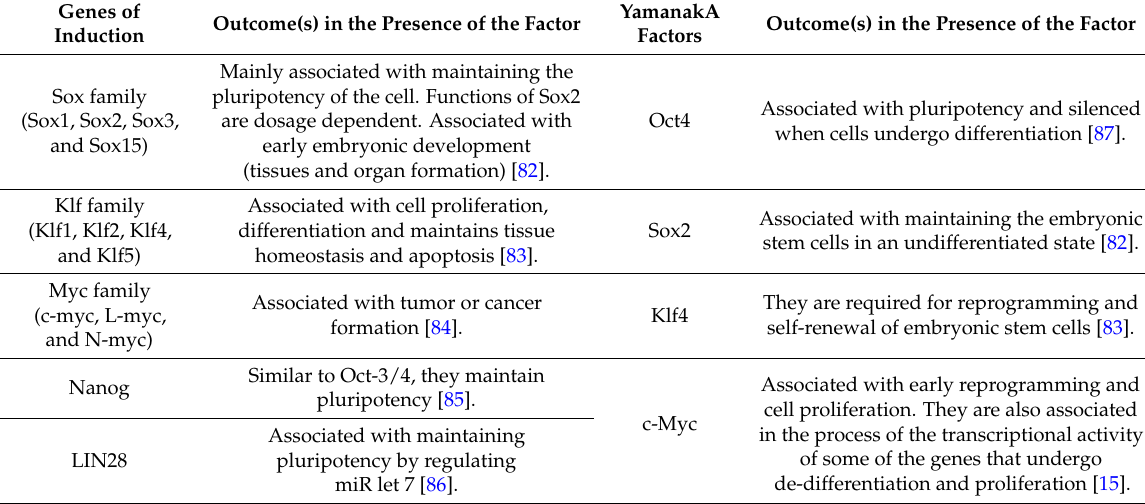
Table 5. Role of different genetic factors involved in stem cell reprogramming. Summarizes the different genetic factors and their roles including the Yamanaka factors in reprogramming the stem cells into